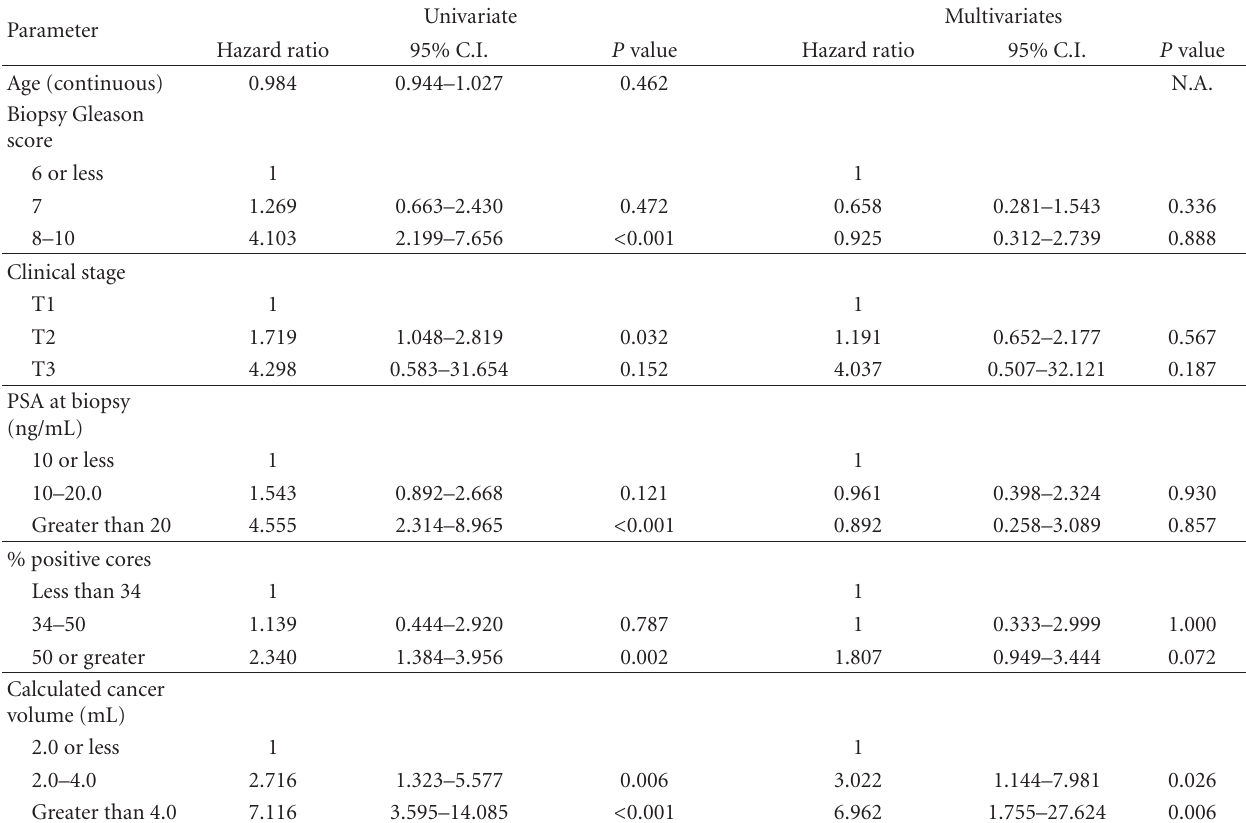
Table 3: Univariate and multivariate analysis in preoperative clinicopathological parameters.